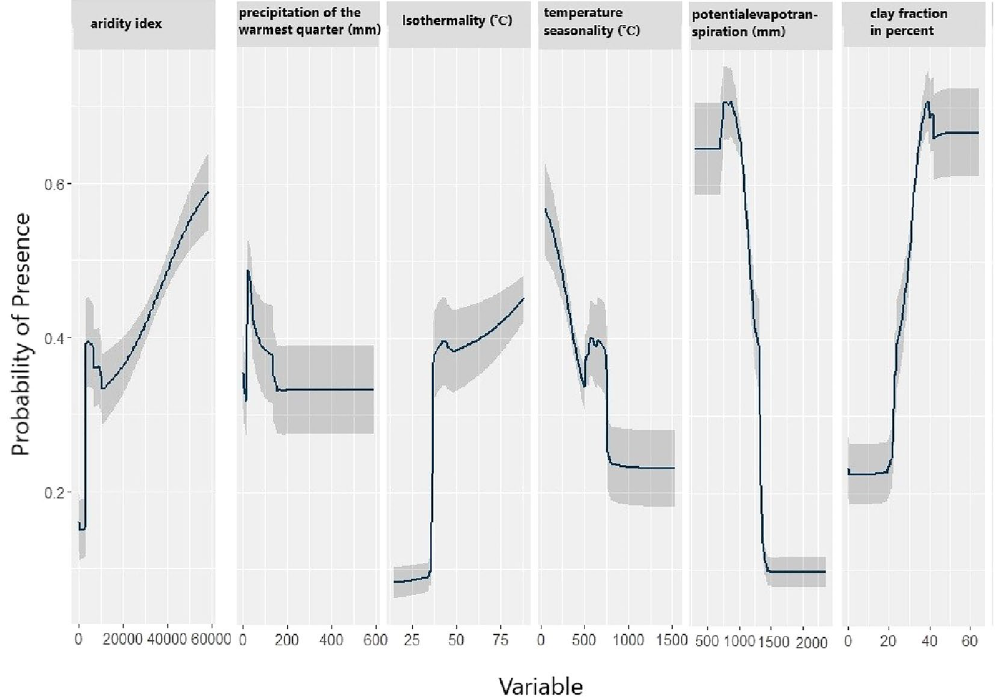
Figure 3. Response curves of the most important predictor variables explaining the potential global distribution of Juniperus phoenicea